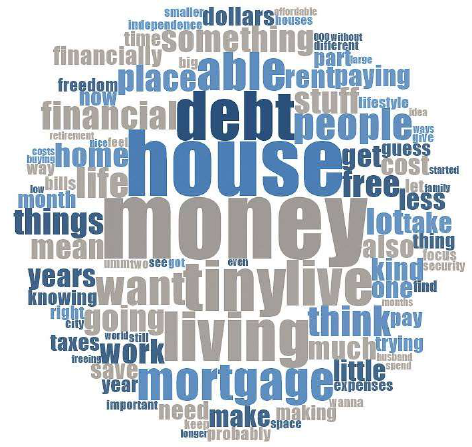
Figure 2. Word cloud for Motivator 1.